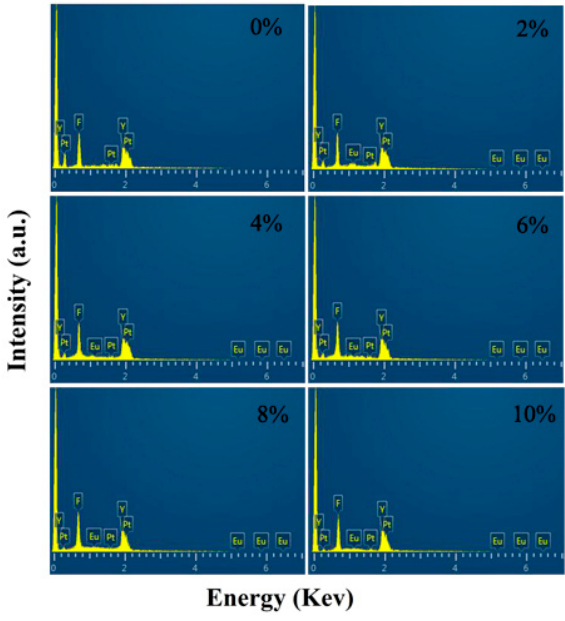
3+ nanocrystals. Figure 2. The EDS spectrum of YF 3 :Eu 3 :Eu